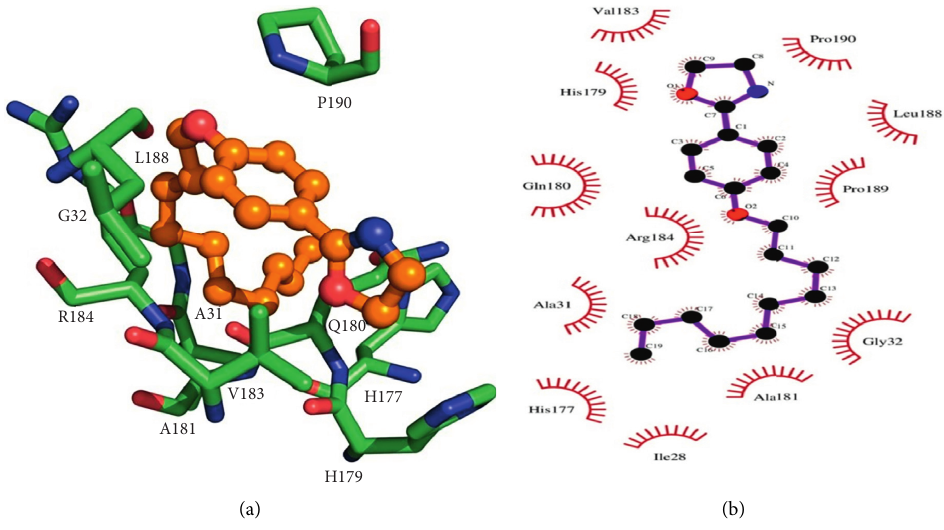
Figure 14: A 2D schematic diagram of the interaction of 18 with